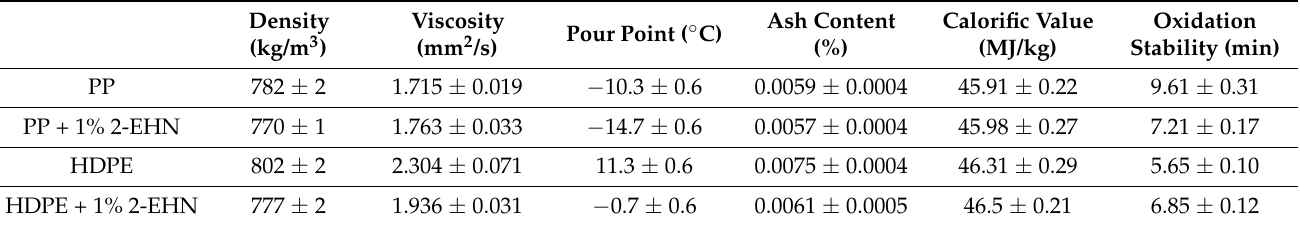
Table 1. Properties of the pyrolysis oils.